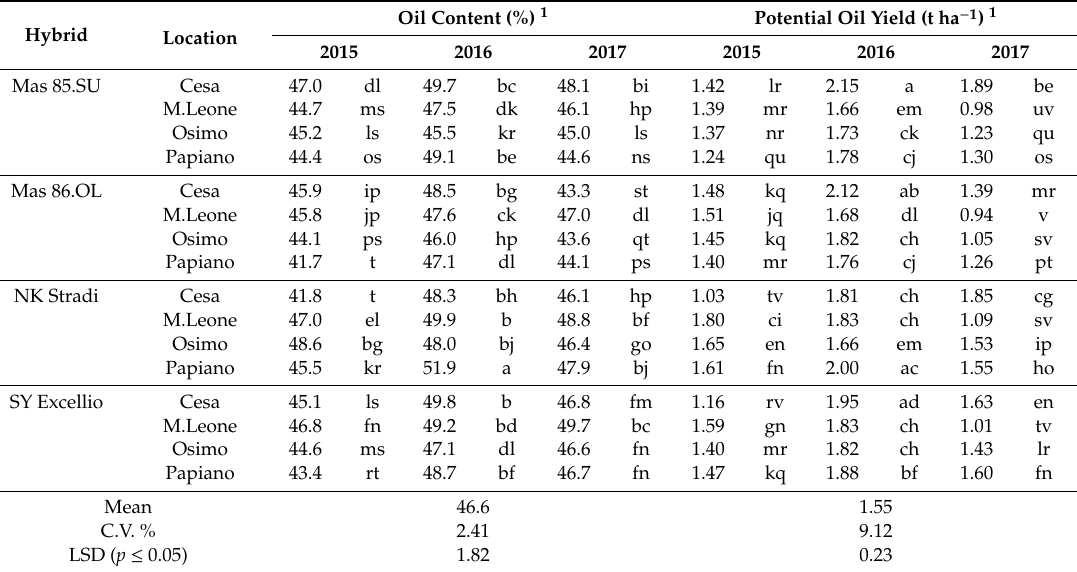
Table 4. Potential oil content and oil yield related to hybrids, locations, and